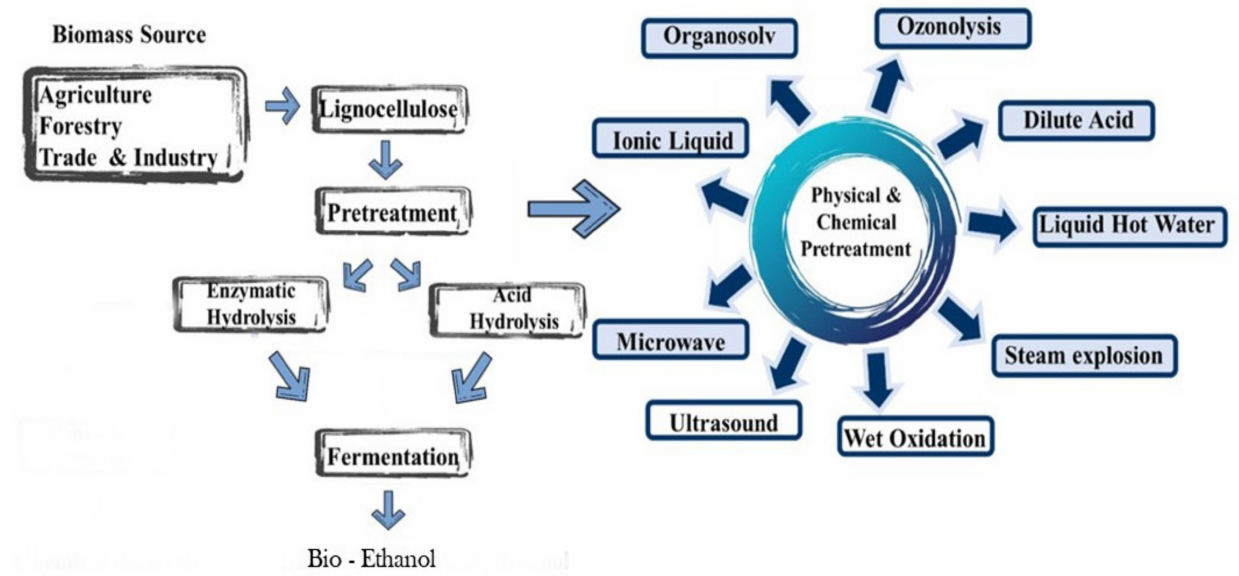
Figure 3. Schematic conversion of the lignocellulose to produce